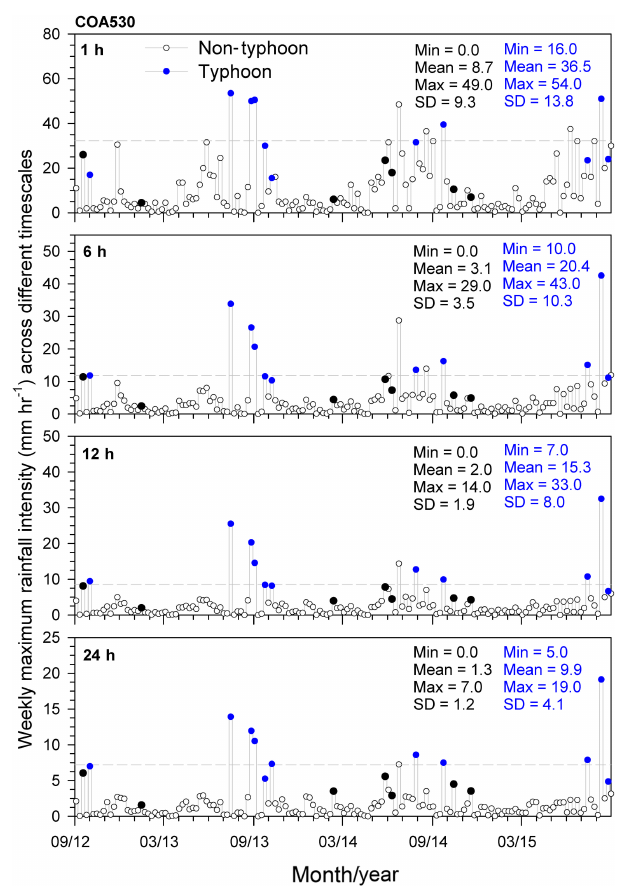
Figure 4. Weekly maximum 1, 6, 12, and 24h precipitation of the rain gauge station COA530 (referring to the location in Fig. 1) used in this study. The black dots are non-typhoon storms with precipita- tion greater than that of the minimal typhoon storms